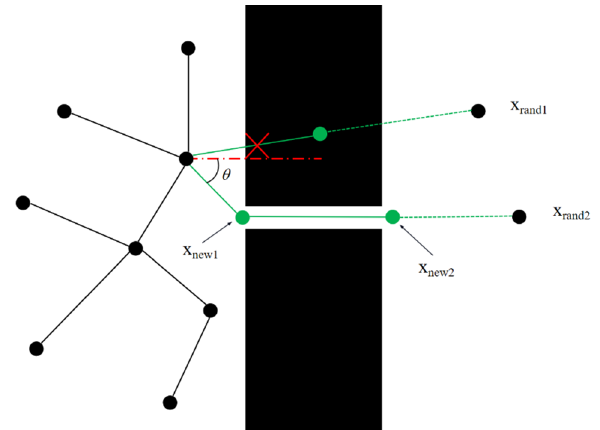
Figure 5. Schematic illustration of random expansion strategy. When the tree T expands towards x rand 1 , it randomly samples a direction θ to expand because it collides with an obstacle. In this way, the Fast-Expand samples another random tree and provides a successful pass through the narrow channel after getting 𝑥 (cid:3045)(cid:3028)(cid:3041)(cid:3031)(cid:2870) in the next sampling.